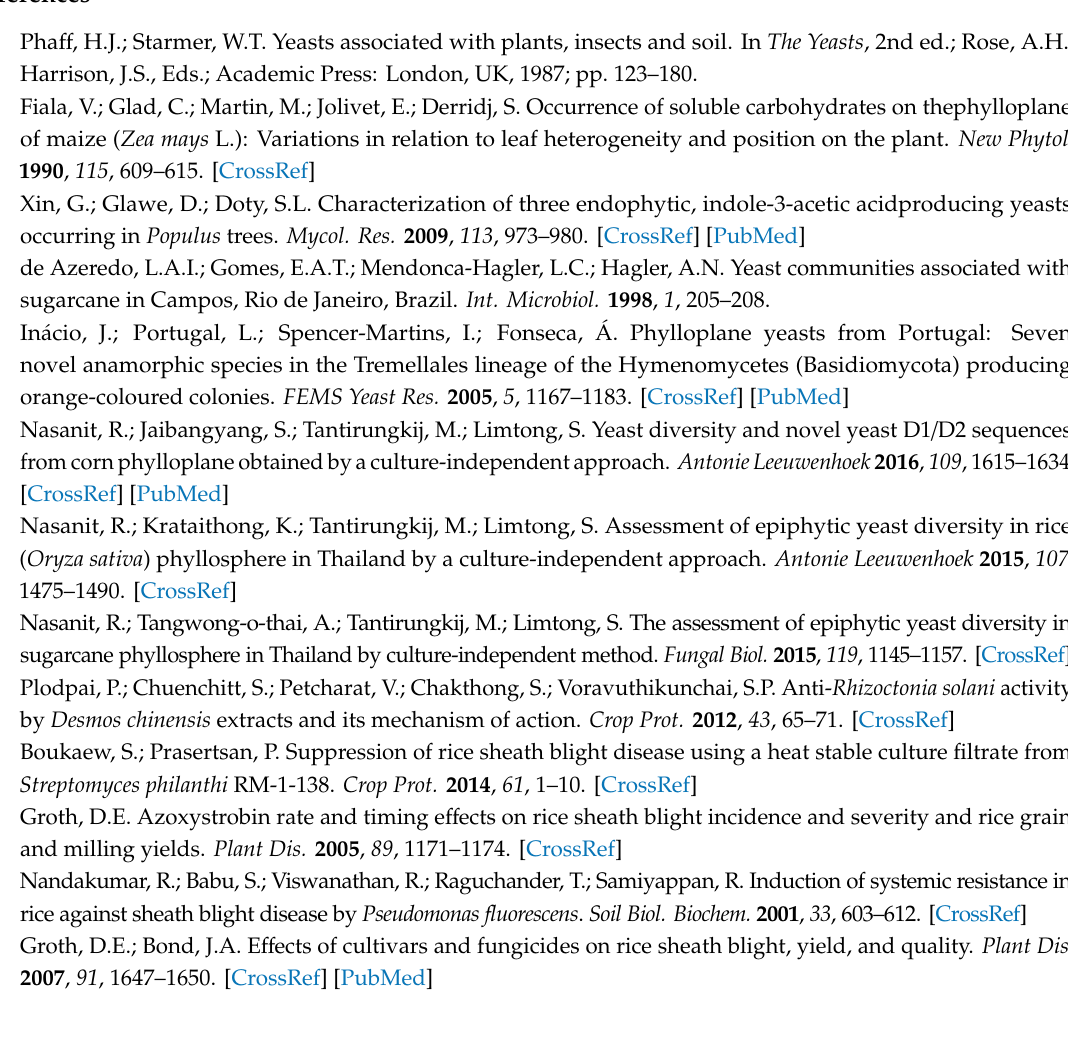
Table S1: Sequence similarity analysis of the D1 / D2 domain of rice phylloplane yeasts and their closely related species, Table S2: Sequence similarity analysis of the ITS region of corn phylloplane isolates showing ≥ 2 nucleotide substitutions in the D1 / D2 region, Figure S1: Phylogenetic relationship of the sequences of the D1 / D2 region of the LSU rRNA gene of yeast strains isolated from the phylloplane of rice belonging to the phylum Ascomycota, subphylum Saccharomycotina and their closely related yeast, Figure S2: Phylogenetic relationship of the sequences of the D1 / D2 region of the LSU rRNA gene of yeast strains isolated from the phylloplane of rice belonging to the phylum Basidiomycota and their closely related